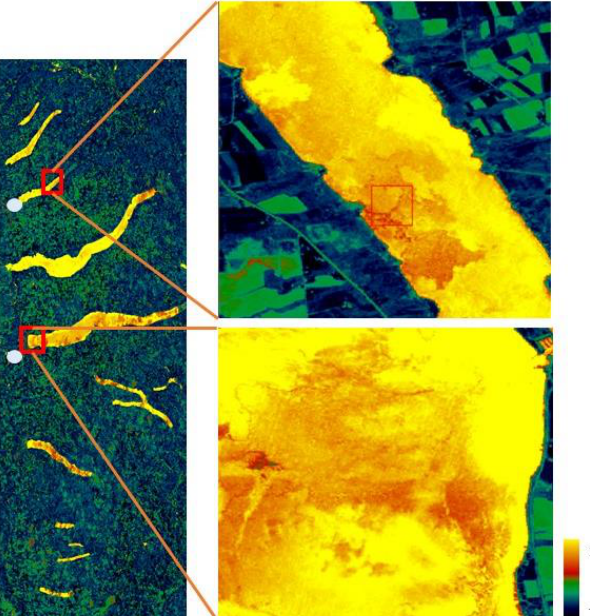
Figure 3 : Two highlighted regions from the study area. Top: Owasco Lake. Bottom: Seneca Lake